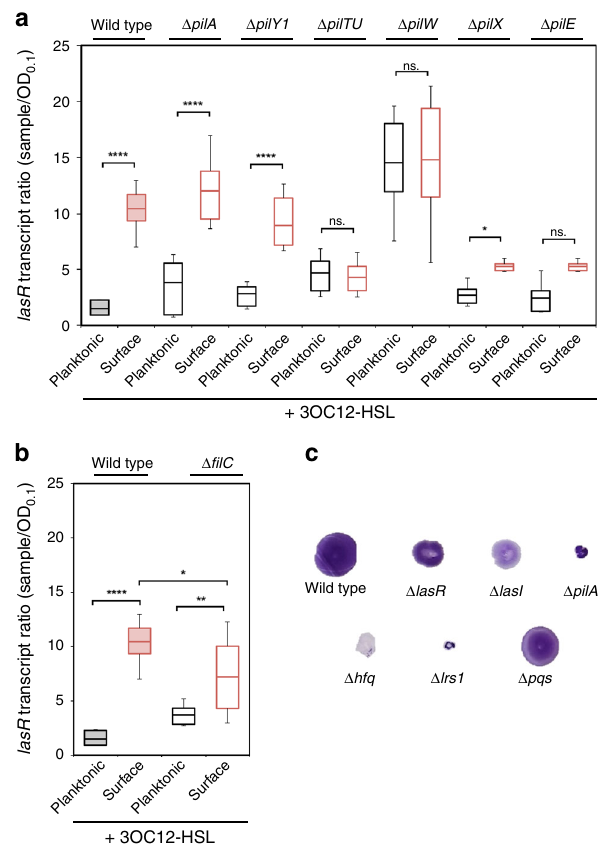
Fig. 4 Surface-primed QS is mediated through TFP retraction motors and minor pilins. a lasR abundance as measured by qRT-PCR in TFP mutants: Δ pilA , Δ pilY1 , Δ pilTU , Δ pilW , Δ pilX , and Δ pilE . b lasR abundance as measured by qRT-PCR in fl agella mutant Δ fl iC . c TFP-dependent twitching phenotype in QS ( Δ lasR , Δ lasI ) and sRNA mutants ( Δ hfq , Δ lrs1 ) with controls Δ pqsA-E and Δ pilA . Error bars in plots represent standard deviation and boxes indicate 25/75 data with the center representing the mean. A two-tailed student ’ s t -test was performed to determine signi fi cance between samples and is denoted by asterisks ( n = 9) (ns. = no signi fi cance, * p <0.01, ** p <0.01, **** p <0.0001). Source data are provided as a Source Data fi